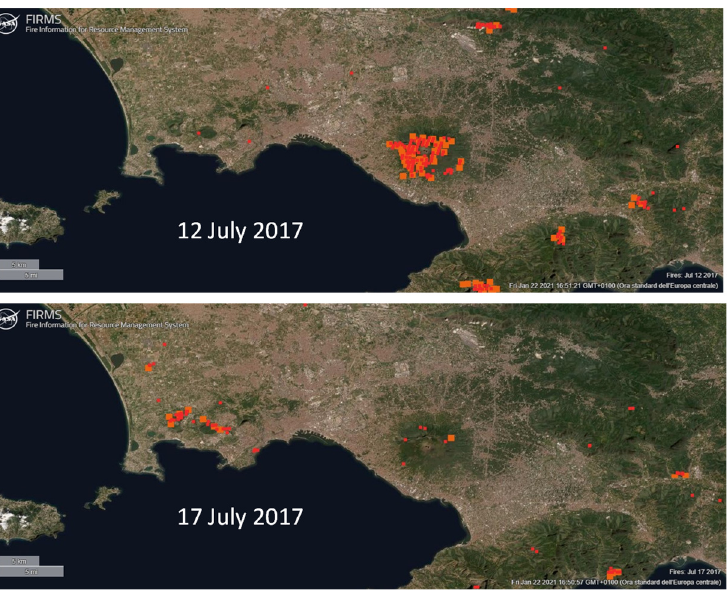
Figure 5. FIRMS maps reporting active fire data (red and orange points) in the measurement area on 12 and 17 of July 2017.